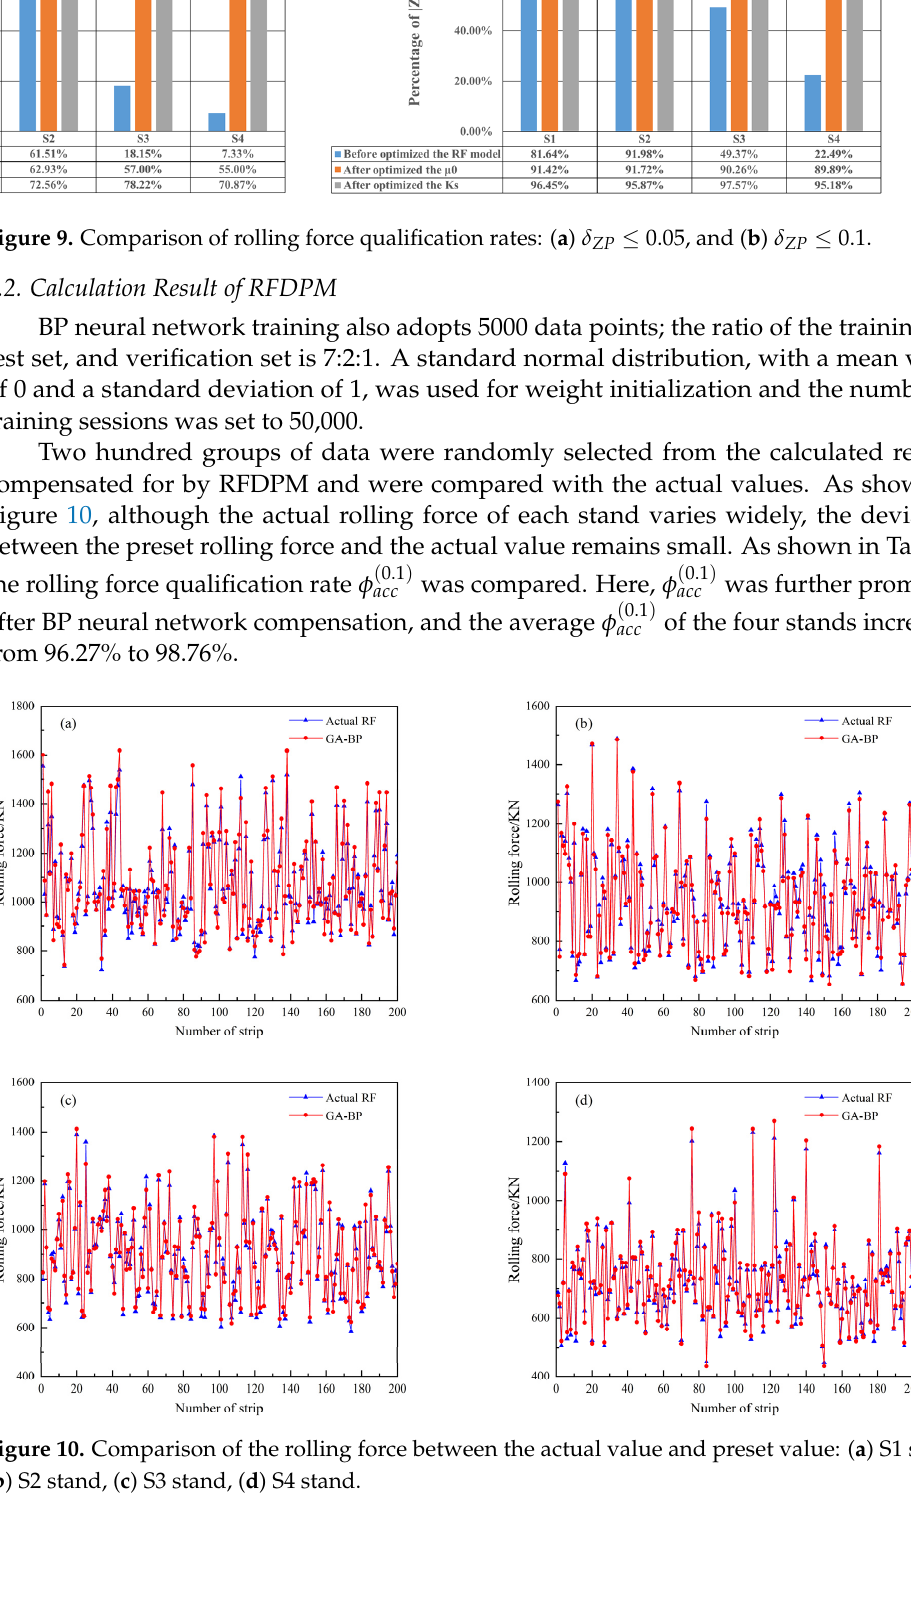
Figure 8. Rolling force calculation result distribution after the optimized deformation resistance model: ( a ) S1 stand, ( b ) S2 stand, ( c ) S3 stand, and ( d ) S4 stand.